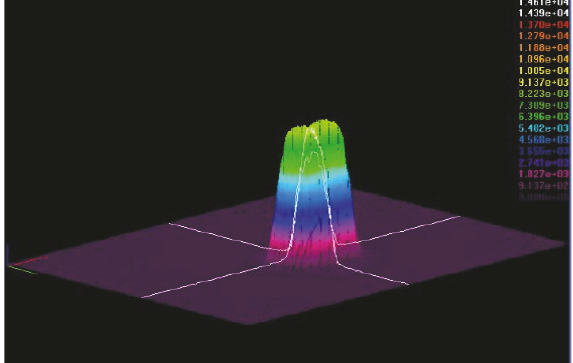
Figure 9: Intensity curve for